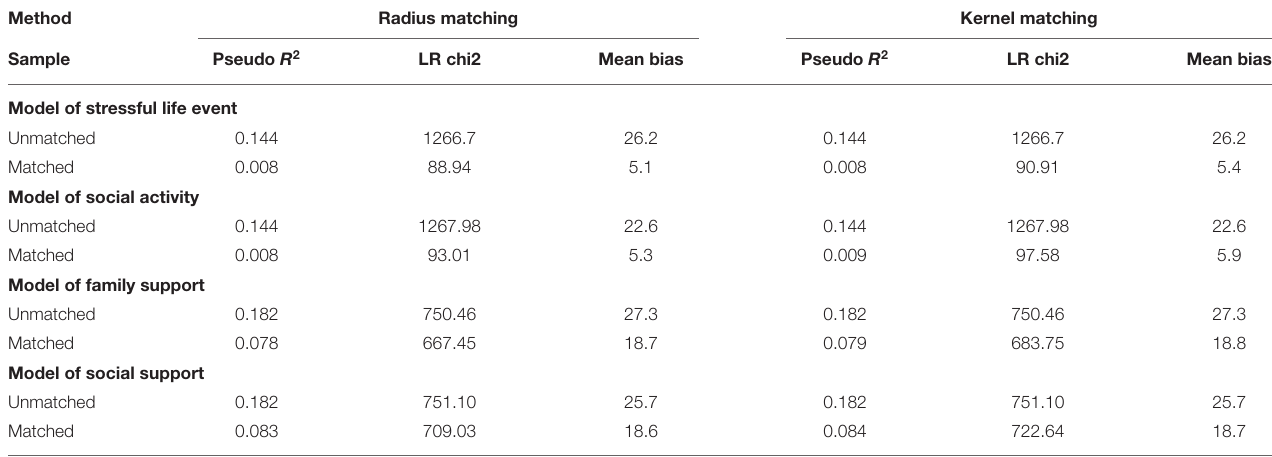
TABLE 4 | Result comparisons of data balancing test under the method of radius and kernel matching in propensity score matching